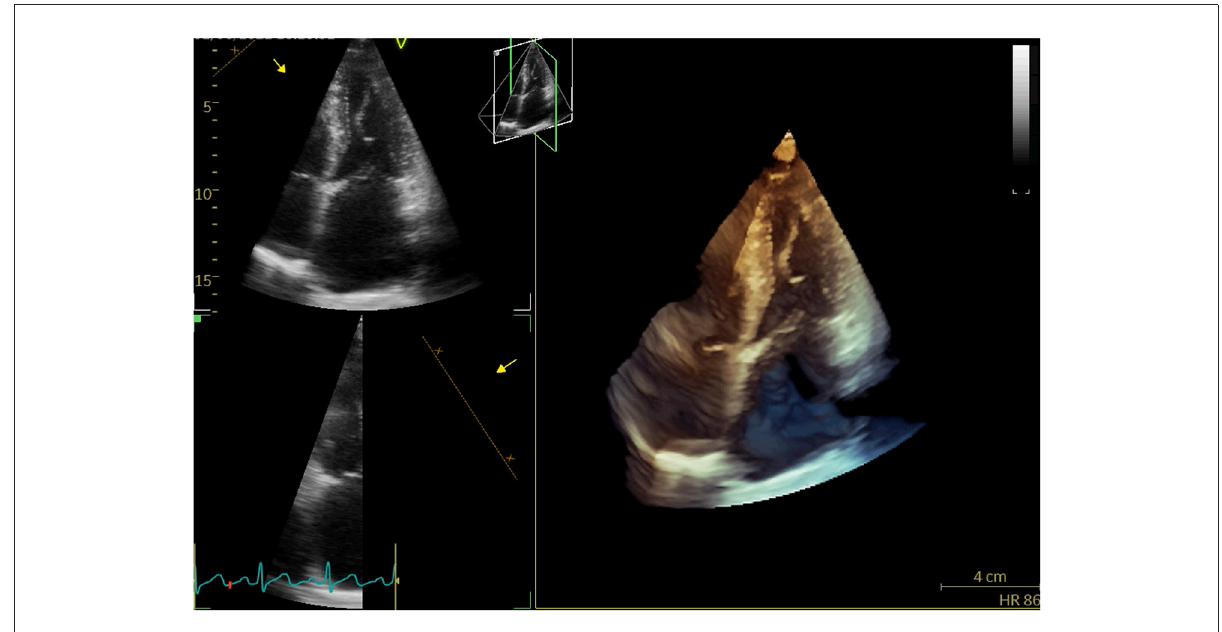
FIGURE1 3D-TTE revealed detached artificial